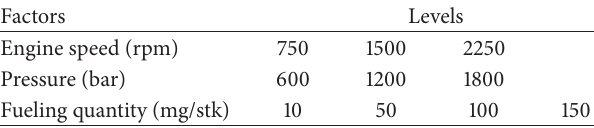
Table 1: DOE fixed factors and their